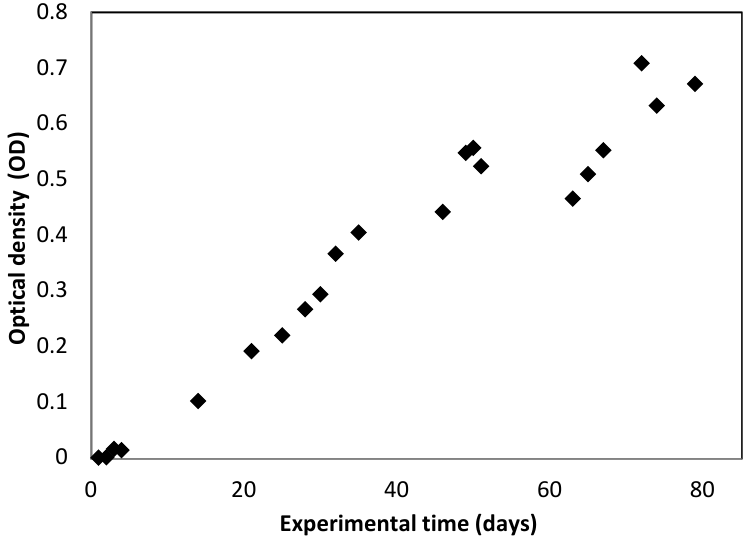
Figure 3. Evolution of optical density (OD) in the photobioreactor during the experimental period.